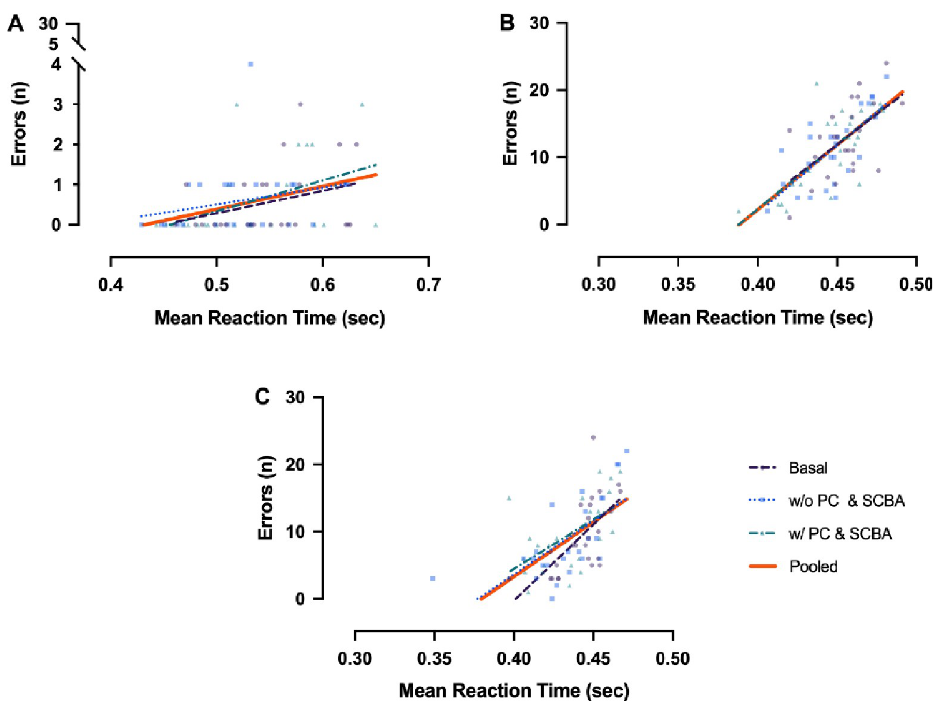
Fig 5. Correlations between the mean reaction time and the errors made in basal, without equipment (w/o PC & SCBA), and with equipment (w/ PC & SCBA) conditions in each trial (A: 1–1 s; B: 0.5–1 s, C: 0.5–0.5 s); the pooled lines (in orange) are also